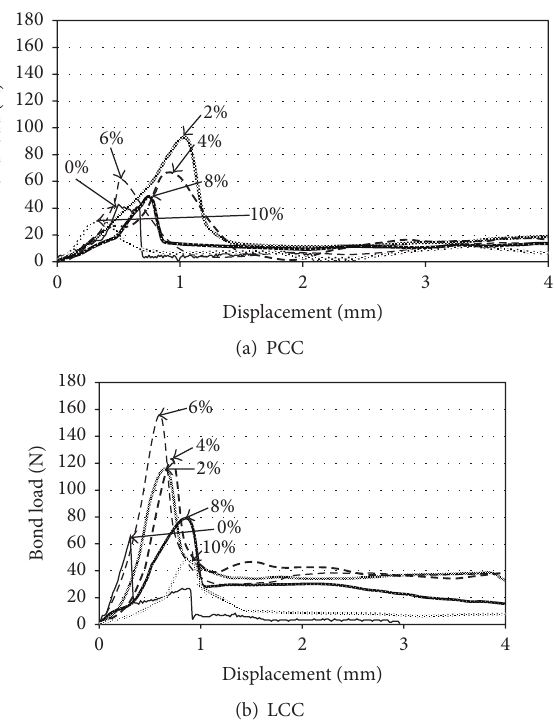
Figure 4: Pullout behavior of macro PP fiber in PCC and LCC with nanosilica